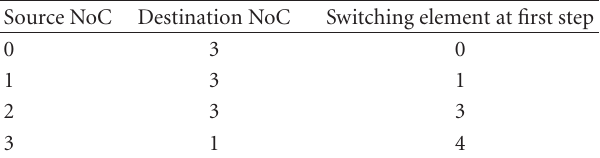
Table 2: Intermediate SE information while data moves from source NoC to destination NoC at first step of best case.